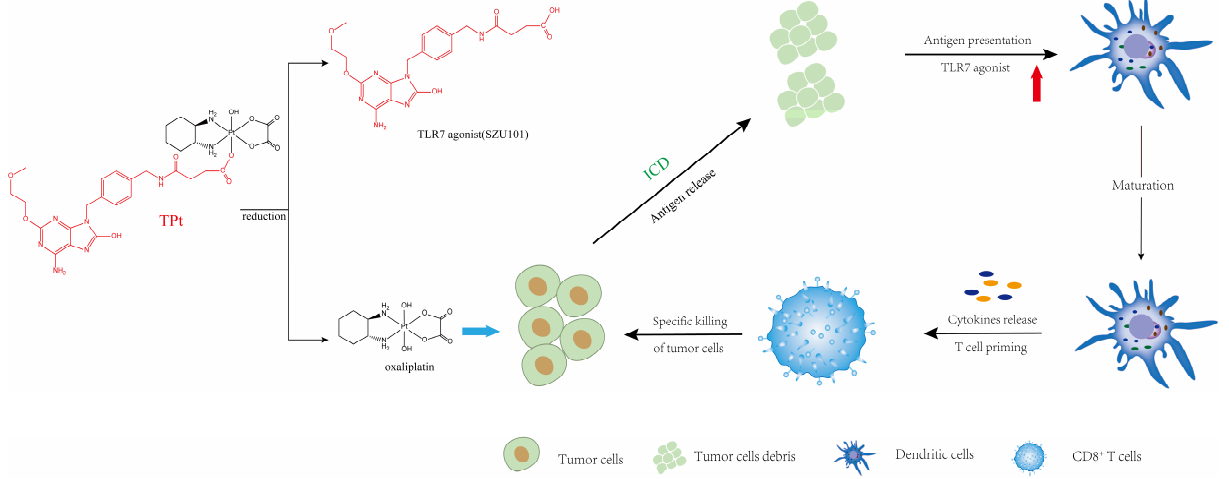
Figure 4. Scheme of combinations with immune agonists to improve T-cell responses. Immune agonists, such as a TLR7 agonist, conjugated with oxaliplatin, can accelerate T-cell maturation, activating prime T cells into mature T cells. Mature T cells release cytokines and exert specific killing effects on tumor cells. Antigens, released by tumor cells going through immunogenic cell death, will perform a synergistic effect with immune agonists to improve T-cell responses to tumor cells. Reprinted with permission from Ref.